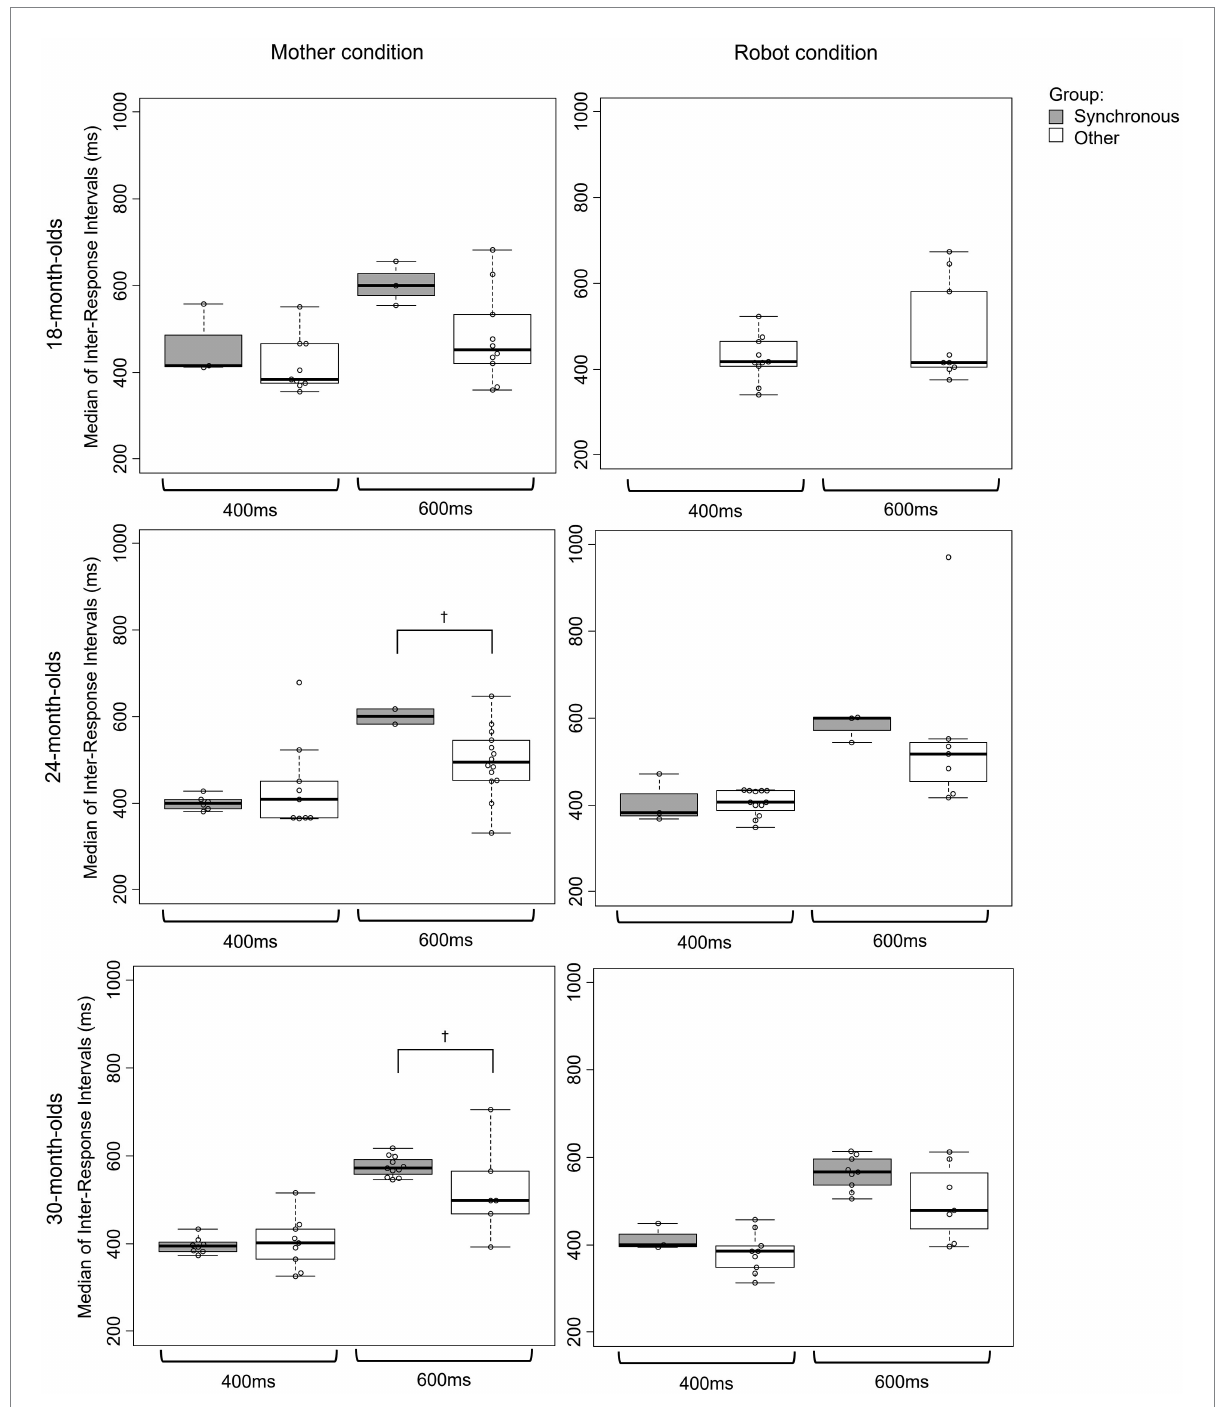
FIGURE 4 Relationship between the abilities of synchronization and tempo